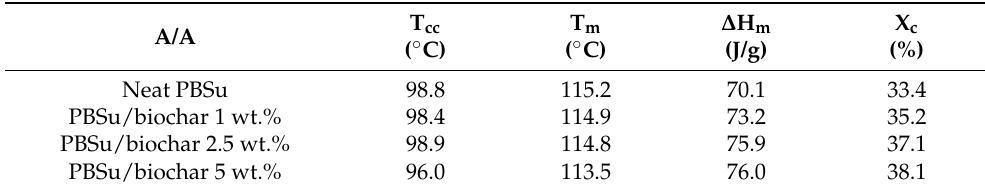
Table 1. Melting temperature, T m , enthalpy of fusion, ∆ H m , and absolute degree of crystallinity, X c , of neat PBSu and PBSu/biochar composites filled with various filler content at a heating rate of 20 ◦